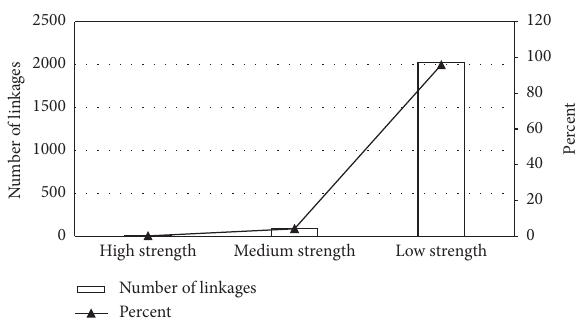
Figure 2: Linkage strength in China’s intercity innovation net- works for 2014.